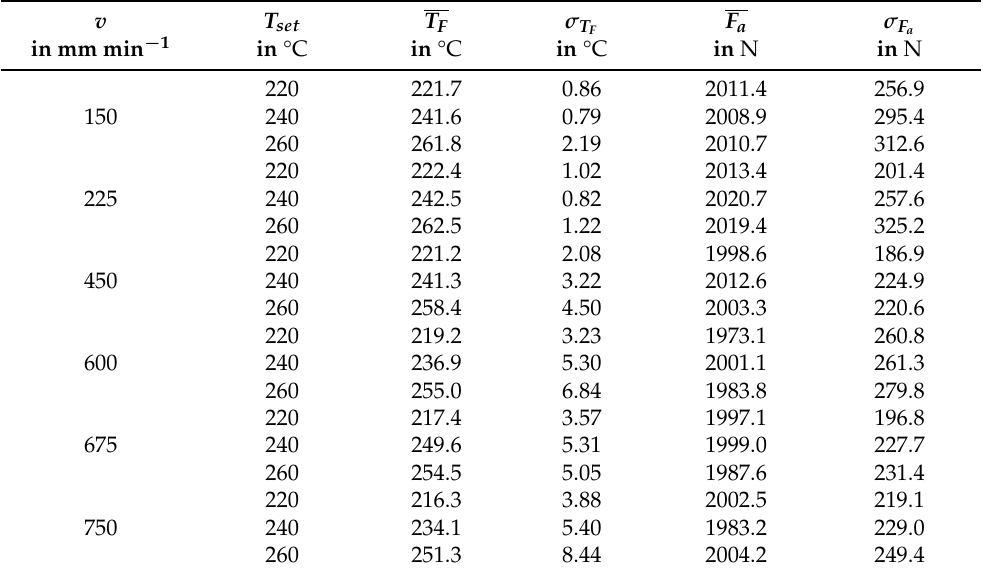
Table 4. Mean temperature T F in °C and mean axial force F a in N, and the corresponding standard deviations ( σ T and σ F ) of the validation experiments. F a